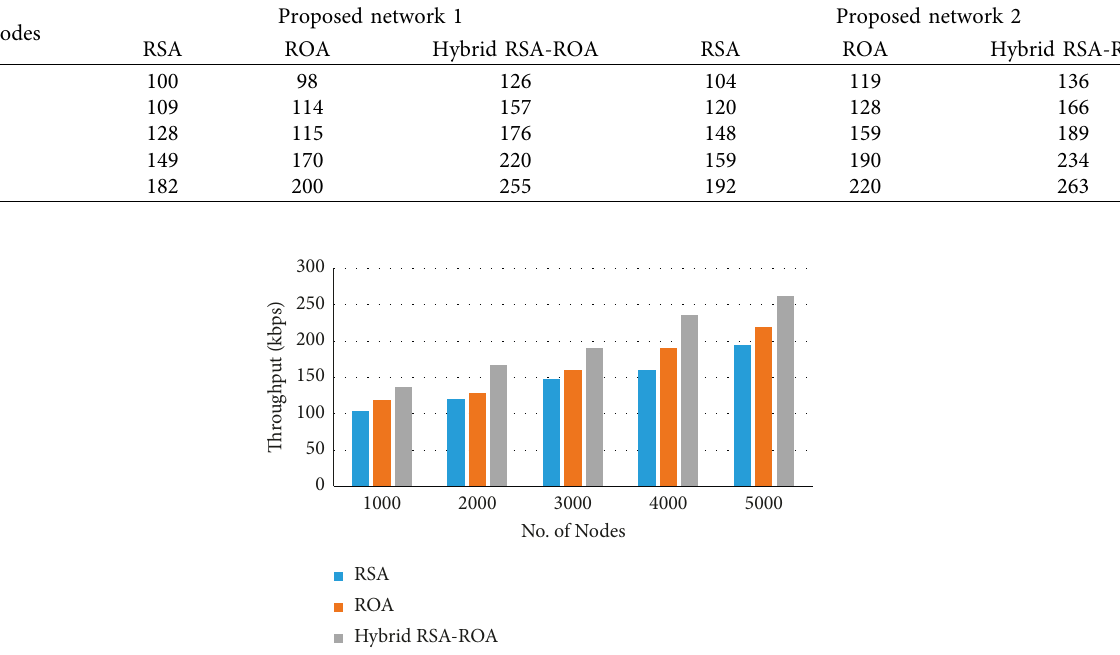
Table 10: Validated analysis of the proposed method for throughput (kbps).